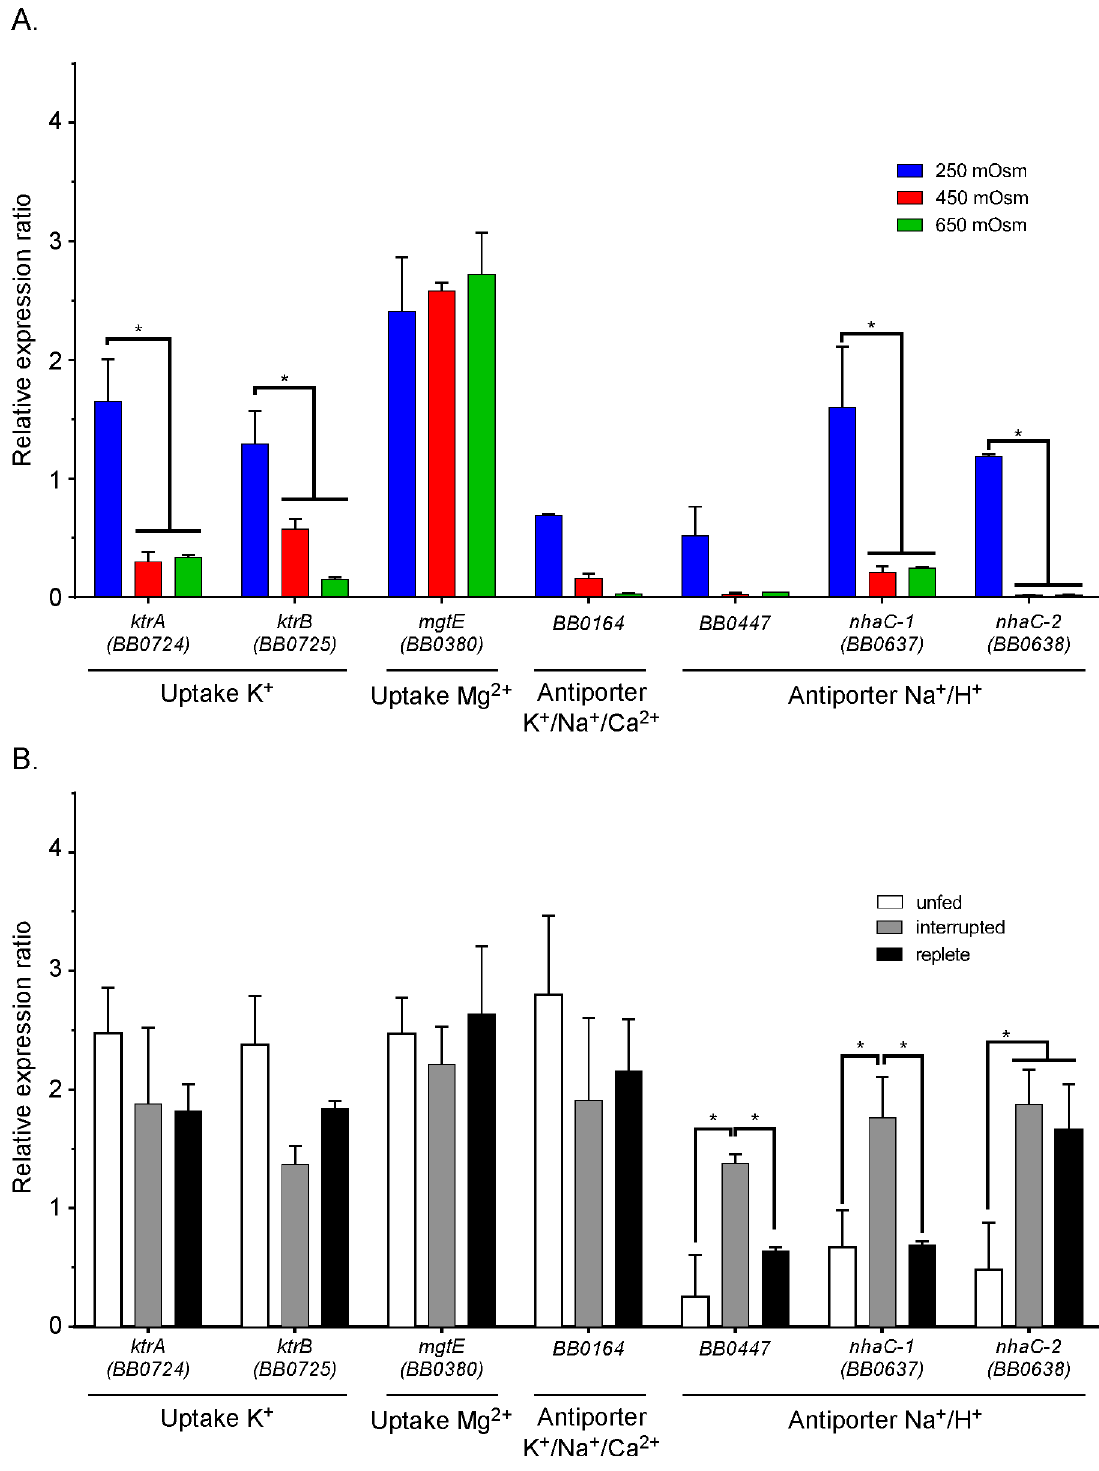
Fig 8. Expression of genes encoding putative ion transporters. (A) Expression analyses of different ion transporter genes of B . burgdorferi grown in BSK-II at 250, 450 and 650 mOsm. (B) Same as A except measured in unfed, partially fed and replete I . scapularis infected with B . burgdorferi . Gene expression was normalized to enoS